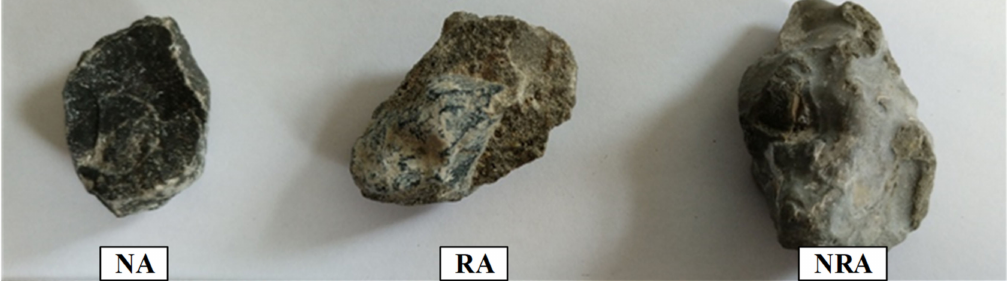
Figure 2. Surface morphologies of natural aggregate (NA), recycled aggregate (RA) and nano recycled aggregate (NRA).